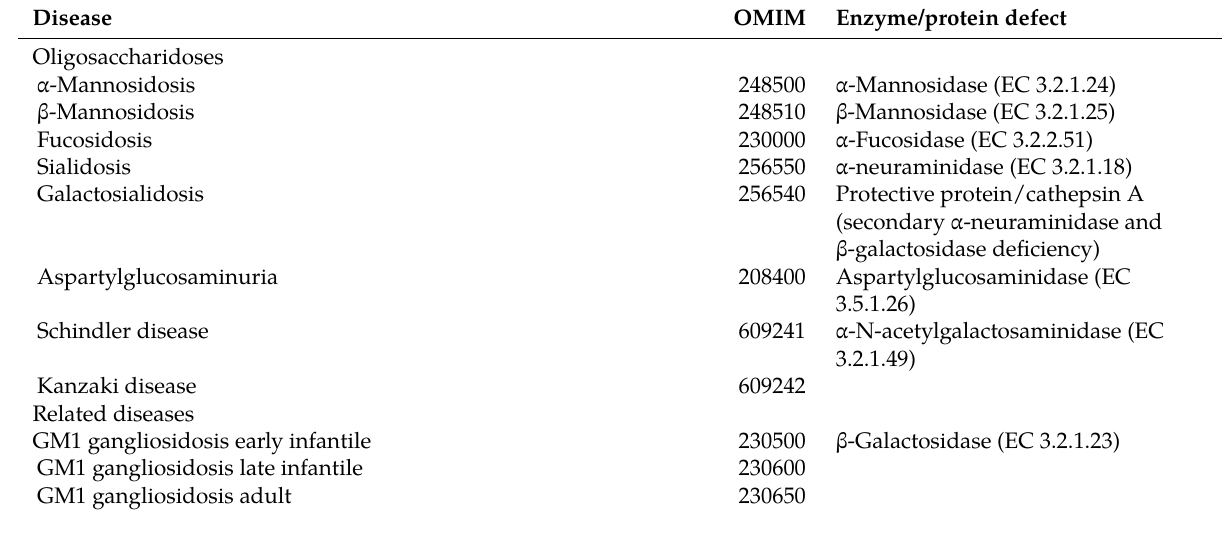
Table 1: Oligosaccharidoses and related disorders with